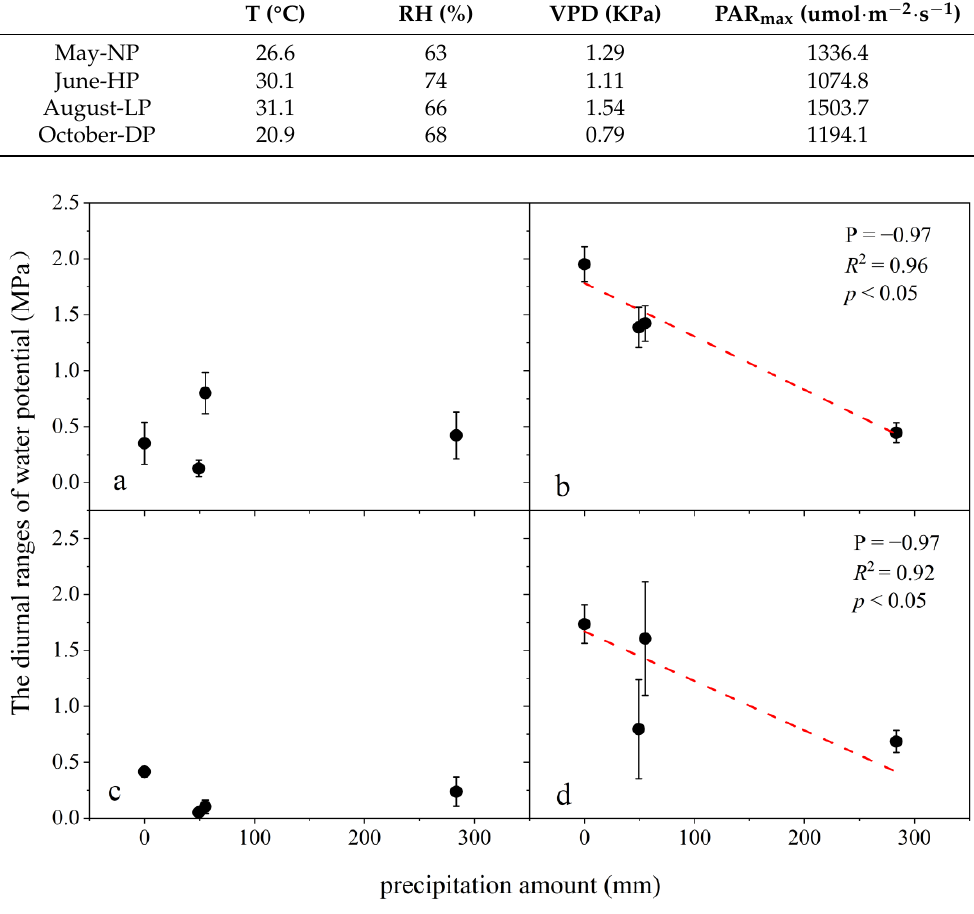
Table 2. The variations in meteorological factors during the sampling dates.